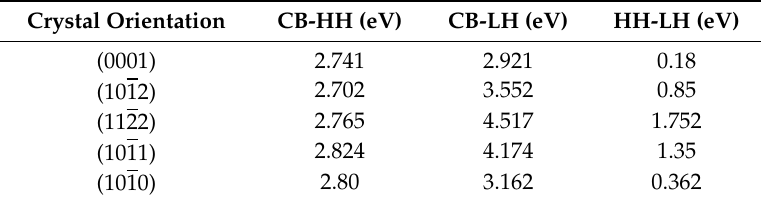
Table 3. Energy separation in di ff erent crystal Table 3. Energy se p aration in different crystal orientation.